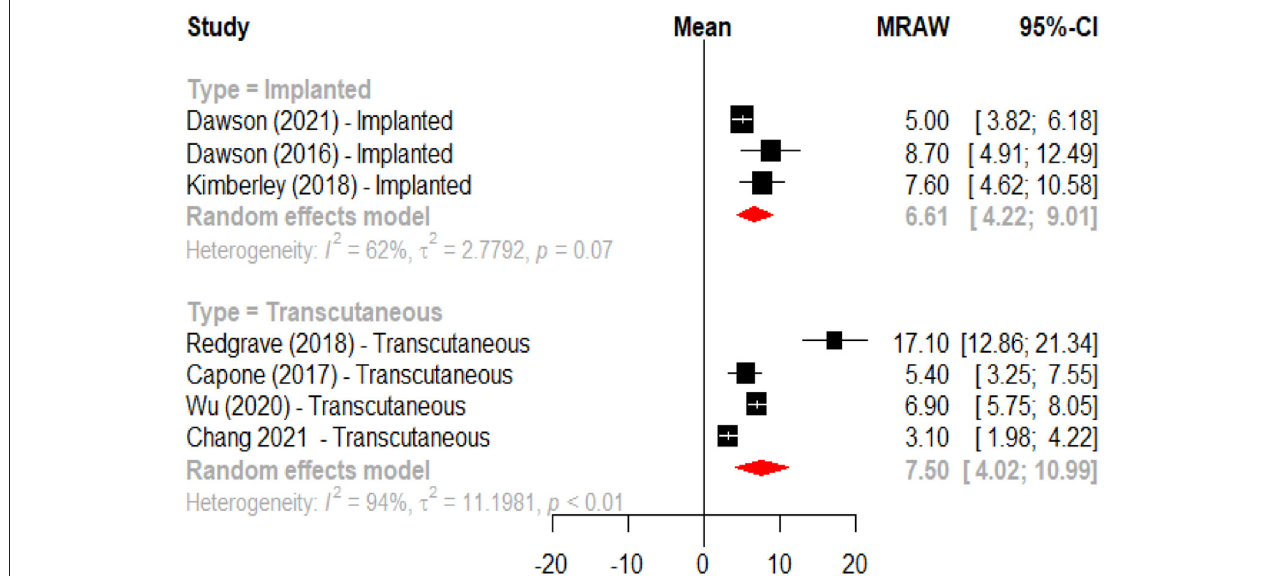
FIGURE 5 | Forest plot for the meta-analysis of vagus nerve stimulation effects on upper limb motor function (FMA-UE score increase) when compared to baseline according to intervention modality (implanted vs. transcutaneous).